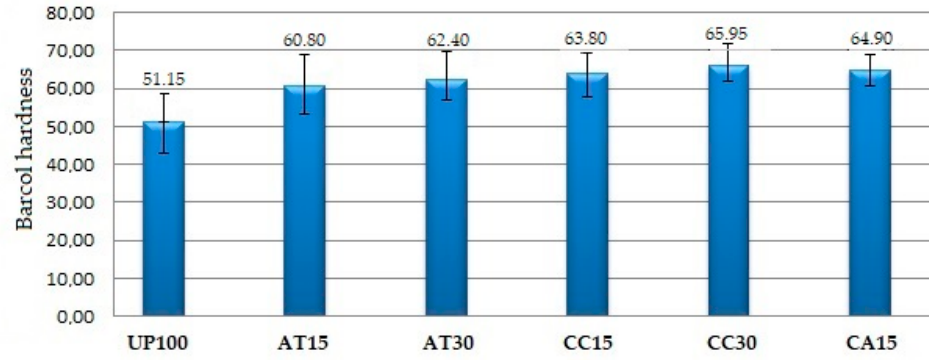
Figure 4. Rate of burning of the GFRP samples.